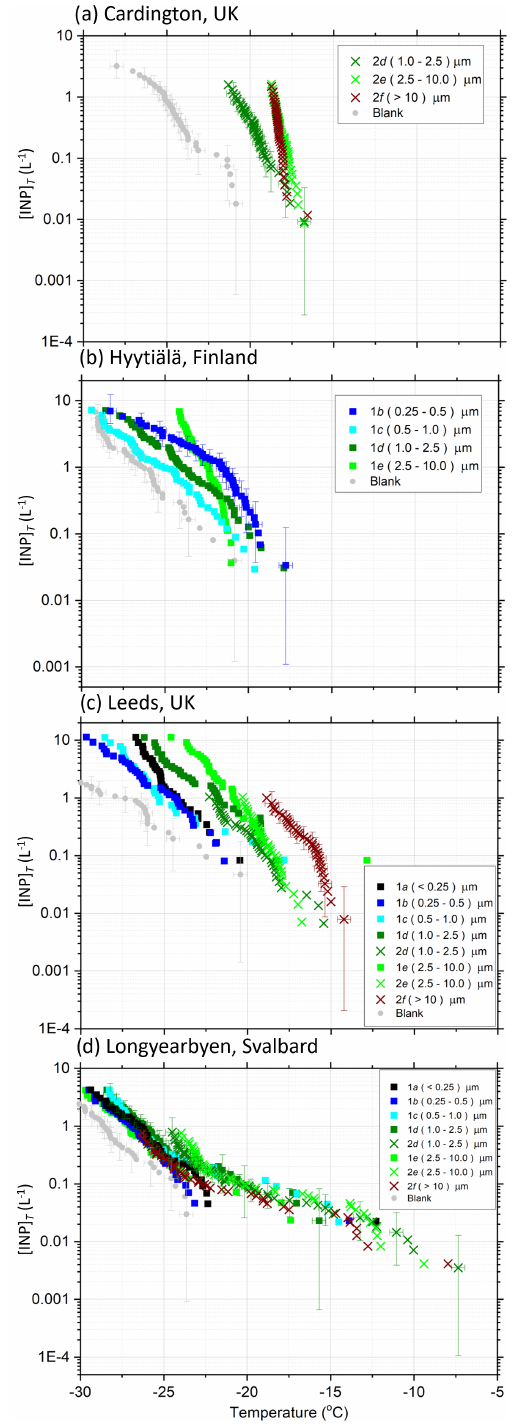
Figure 8. INP concentrations determined from each impactor stage of the SHARK at the four testing sites: (a) Cardington (UK), (b) Hyytiälä (Finland), (c) Leeds (UK), and (d) Longyearbyen (Svalbard). Handling blank data, which determine the baseline of the results, are shown in grey. Samples of the error bars are shown.